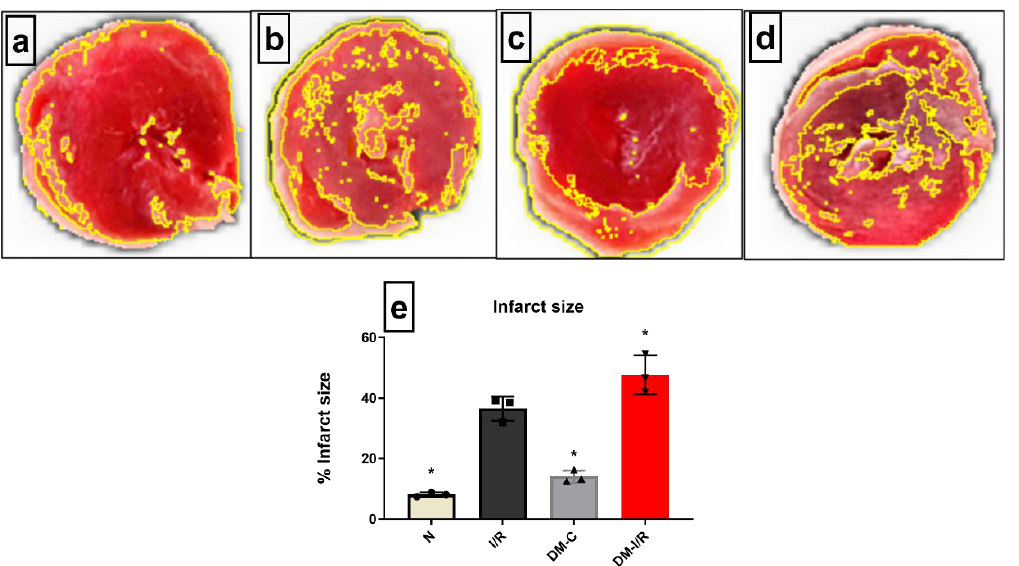
Figure 2. Impact of DM on cardiac I/R injury: The cardiac I/R injury was assessed in DM rat hearts by infarct size measurement of ( a ) normal; ( b ) I/R; ( c ) DM-C and ( d ) DM-I/R hearts. The presented images are representatives from the groups. ( e ) represents the infarct size percentage measurement. The graph represent mean ± SD values. * p < 0.05 vs. N. Table 2. Effect of I/R on cardiac function in diabetic hearts: The impact of diabetes on cardiac I/R were evaluated by the hemodynamic changes LVDP (left ventricular diastolic pressure); RPP (rate pressure product = heart rate × LVDP) and ±dp/dt maximum/minimum force of contraction. The data are represented as mean ± SEM. * p < 0.05 vs. I / R.